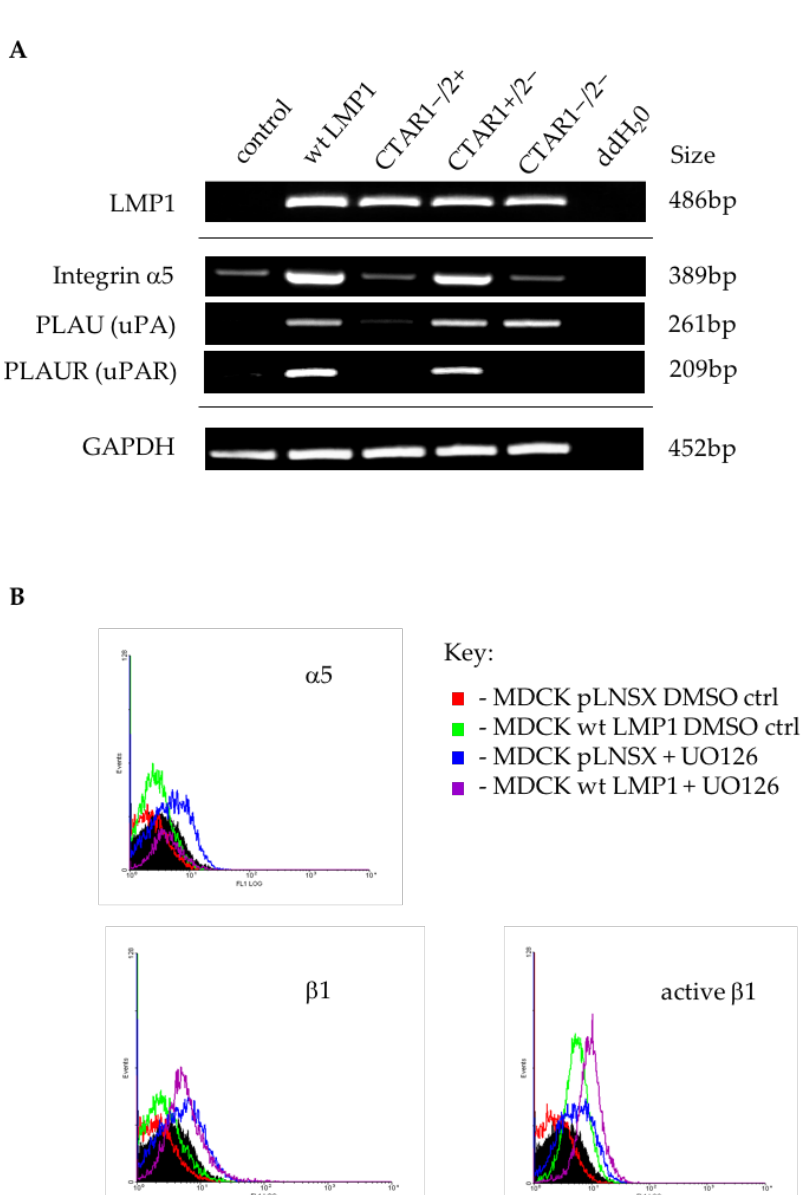
Figure 6. LMP1 deregulates integrin subunit expression. ( A ) RT-PCR confirmed the upregulation of α 5 integrin subunit, as well as urokinase plasminogen activator (uPA) and its receptor, uPAR in wildtype and CTAR1+/2 − LMP1-expressing cells; ( B ) Flow cytometric analysis confirmed an increase in basal levels of α 5 integrin expression on the cell surface of LMP1-expressing cells, but very little increase in basal levels of β 1 integrin. Using an antibody that specifically recognises β 1 integrin in its active conformation demonstrated an increase in β 1 integrin activation on the cell surface of LMP1-expressing cells. This was unaffected by inhibition of ERK-MAPK signalling, since addition of 60 µ M UO126 had no significant effect on cell surface expression of these integrin subunits, active or otherwise.